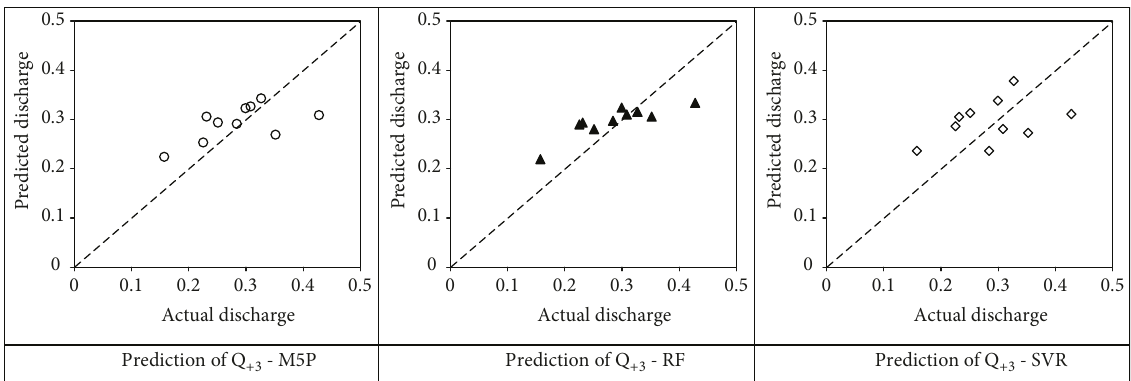
Prediction of Q + 3 - M5P Prediction of Q + 3 - RF Prediction of Q + 3 - Figure 15: Comparison between predicted and observed discharges [m 3 /s], 6-month input.